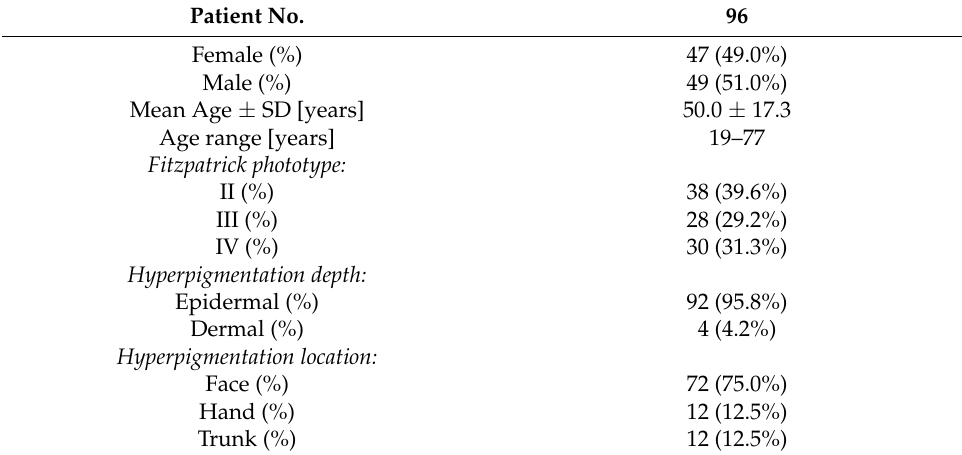
Table 1. Demographic data of included patients.